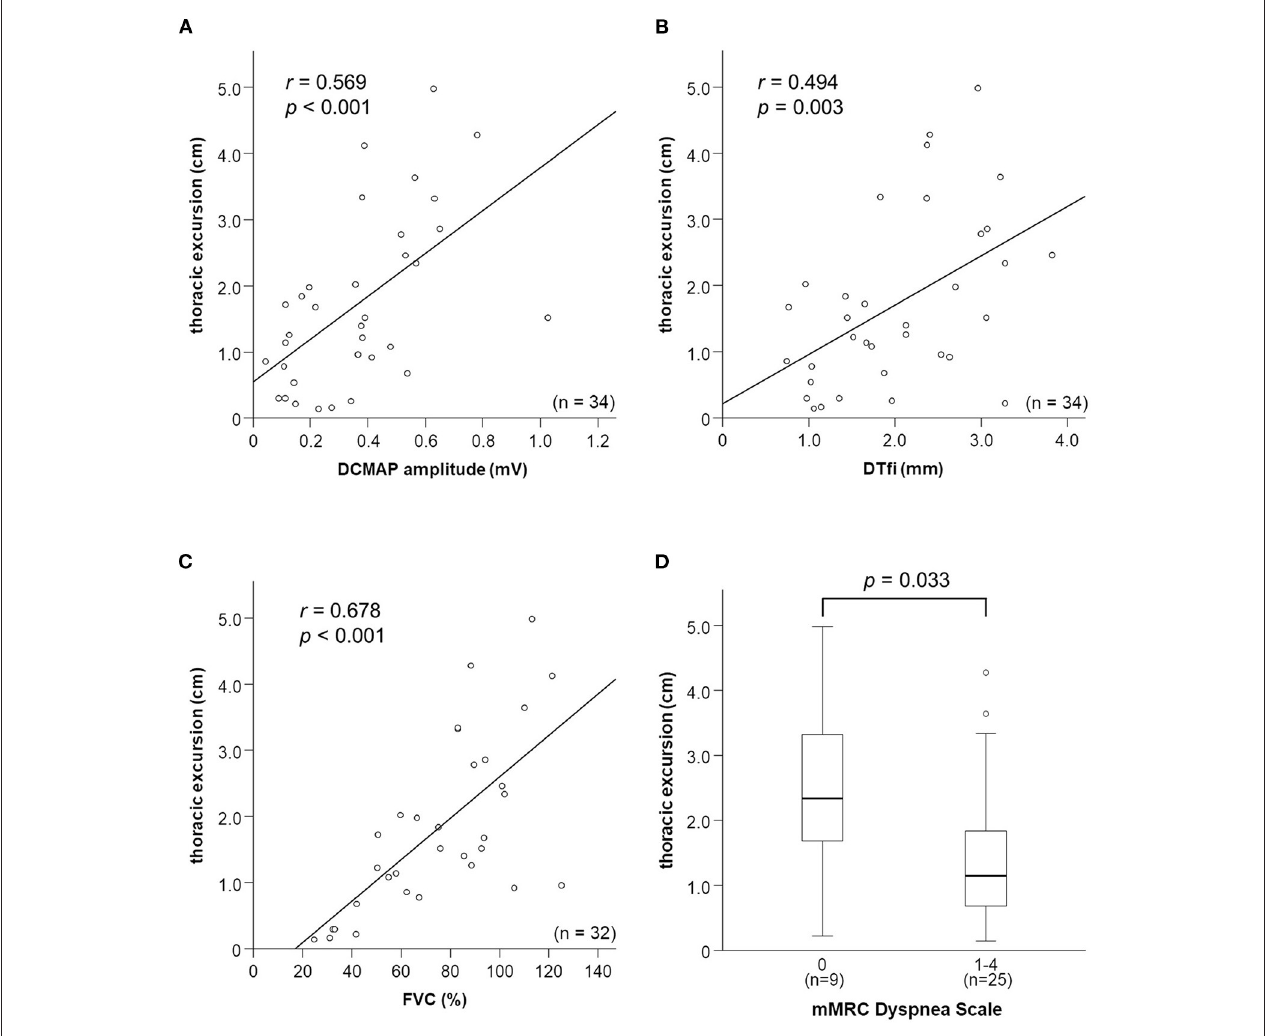
FIGURE 3 | Relationships between thoracic excursion and other neurophysiological parameters, FVC, and mMRC Dyspnea Scale score. (A–C) Relationships between thoracic excursion and DCMAP amplitude, DTfi, and FVC. Thoracic excursion shows a strong correlation with FVC (C) and moderate correlation with DCMAP amplitude (A) and DTfi (B) . (D) Relationships between thoracic excursion and subjective dyspnea severity assessed using the mMRC Dyspnea Scale. Thoracic excursion is the most sensitive parameter for assessing subjective dyspnea. FVC, forced vital capacity; mMRC, modified Medical Research Council; DCMAP, diaphragmatic compound muscle action potential; DTfi, diaphragm thickness at full